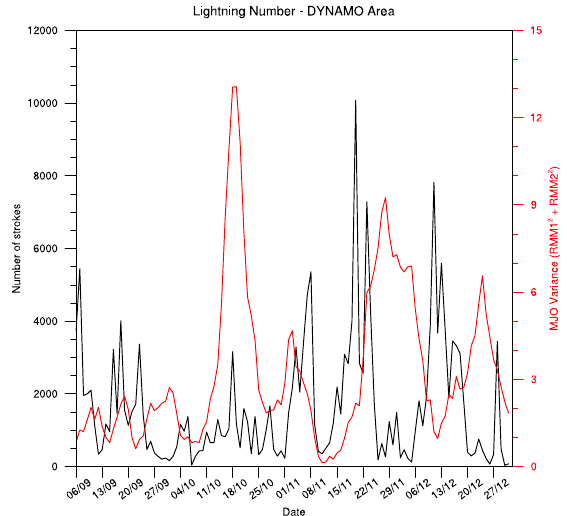
Fig. 5. Daily number of strokes from WWLLN (black) and MJO variance (red) for the period 6 September 2011 to 31 Decem- ber 2011 and for the region 7 ◦ N–11 ◦ S, 65 ◦ E–83 ◦ E.